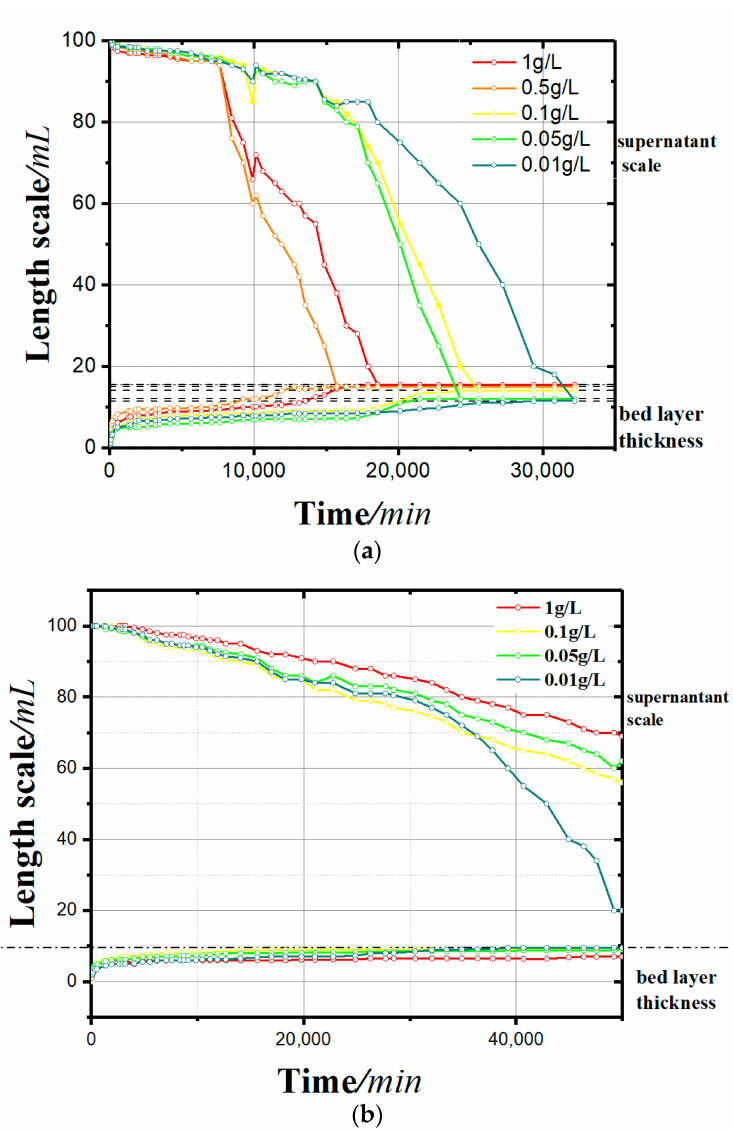
Figure 4. Sedimentation curves: ( a ) with a soluble starch flocculant and ( b ) with an apple pectin